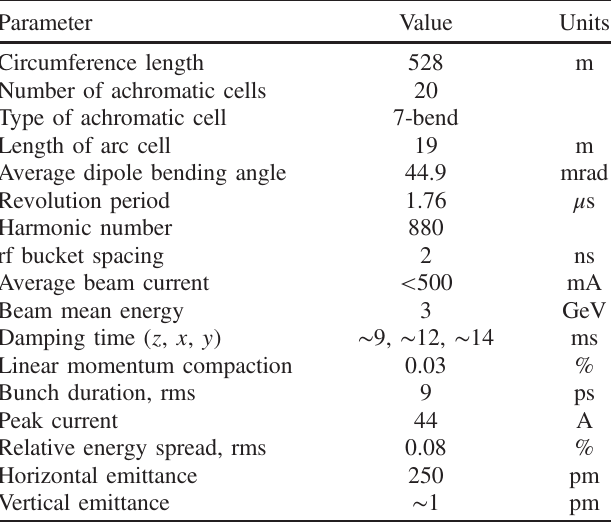
TABLE I. SRLS parameters for standard ID